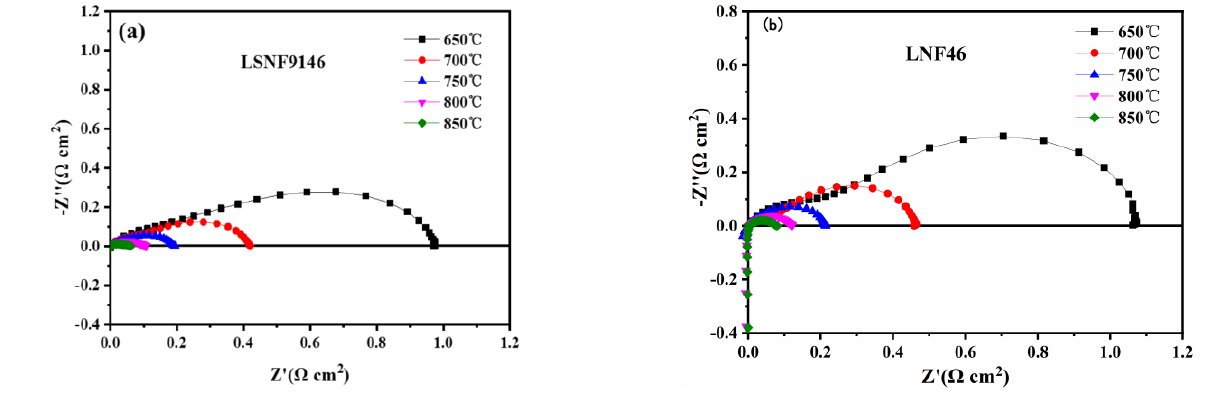
Figure 5. Symmetrical cell performance of ( a ) LSNF9146 and ( b ) LNF46 electrodes in air